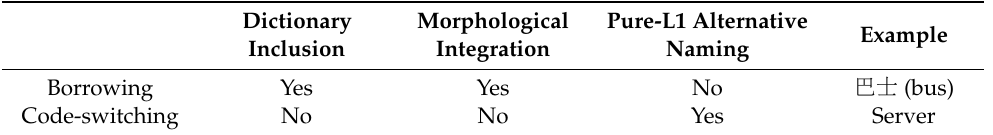
Table 3. Definition of “borrowing” and “code-switch” in this study. We only focused on “code-switch” in this experiment.